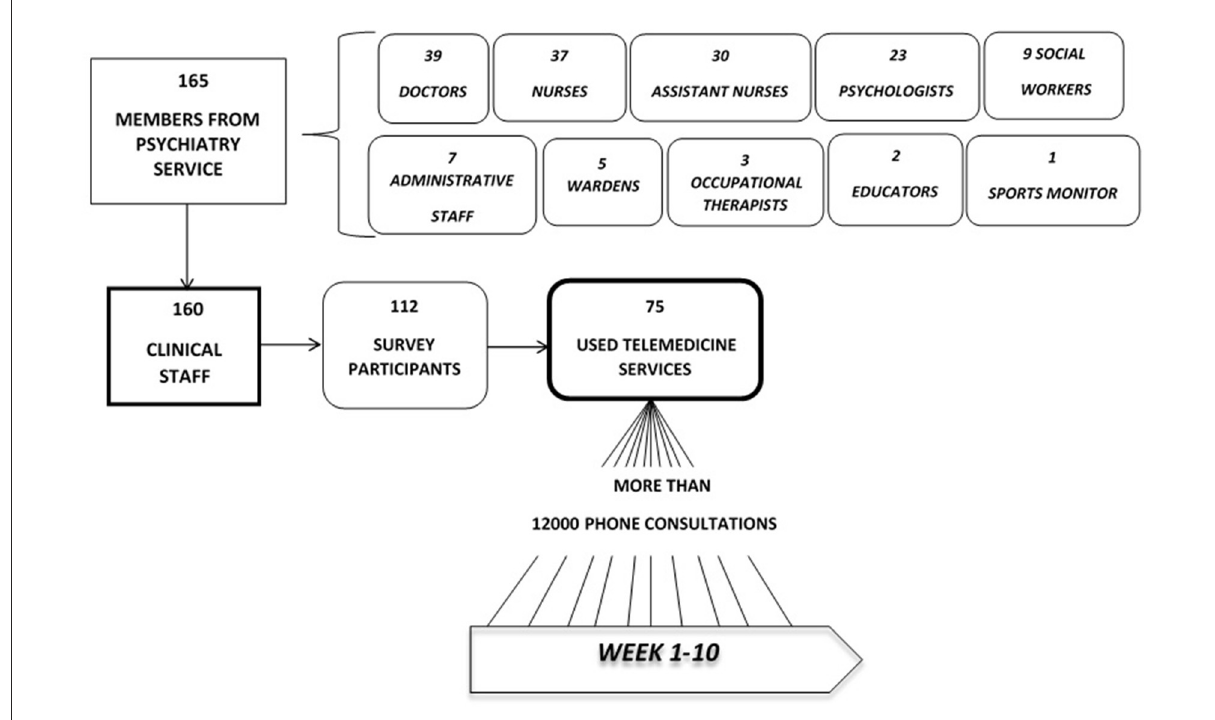
FIGURE1 A summary of the data